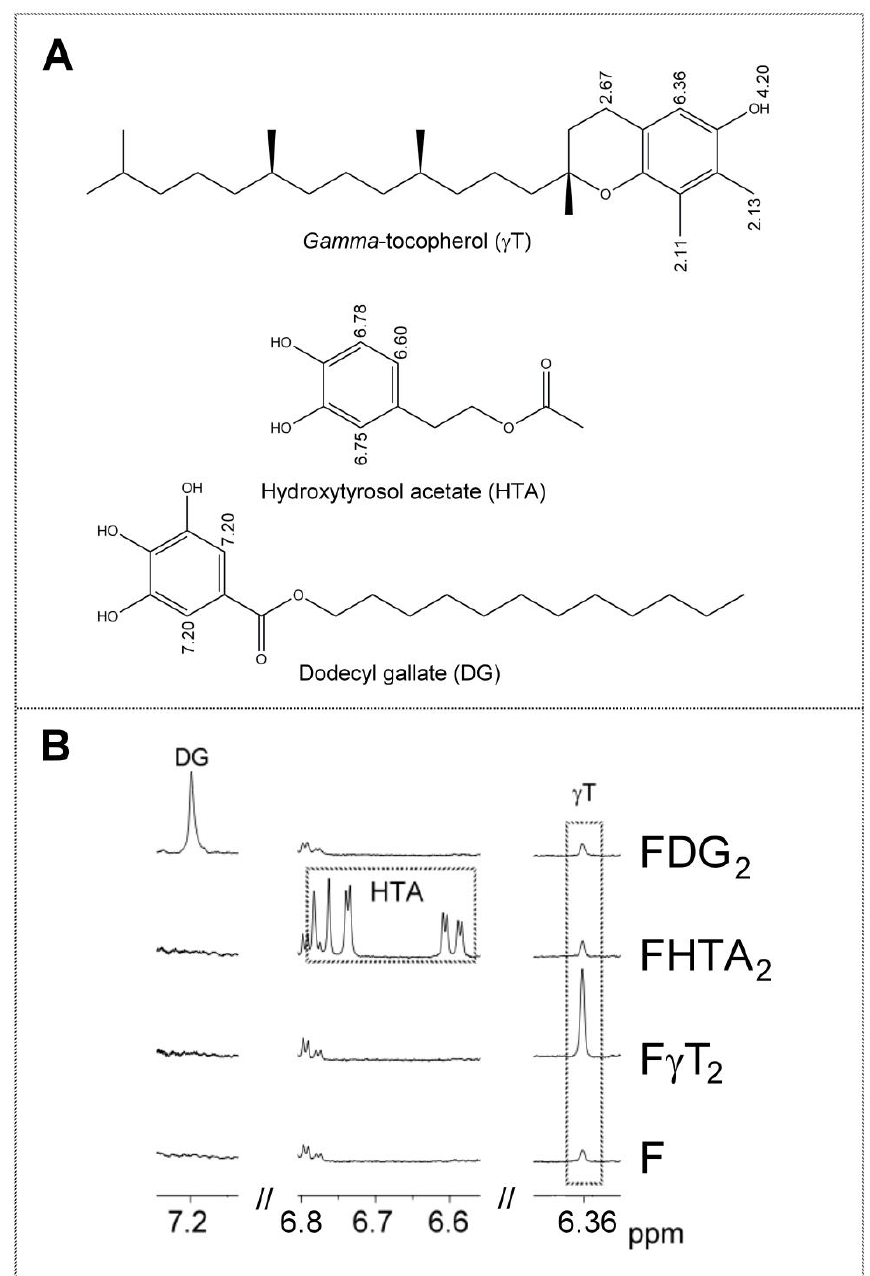
Figure 2. ( A ) Chemical structures of the phenolic compounds involved in this study (gamma-tocopherol γT, hydroxytyrosol acetate (HTA) and dodecyl gallate (DG), together with some chemical shifts (ppm) of the 1 H NMR signals of some of their hydrogen atoms. ( B ) Enlargement of some regions of the 1 H NMR spectra of nonenriched F and some enriched oil samples (FγT 2 , FHTA 2 and FDG 2 ), in which the signals of the aforementioned phenolic compounds appear. The signal letters agree with those of Table S5. (B) Estimation of the Molar Percentage of Fatty Acids Plus Acyl Groups that Have Linolenic Structure in Relation to the Total of All Types of Fatty Acids and Acyl Groups in Digestates